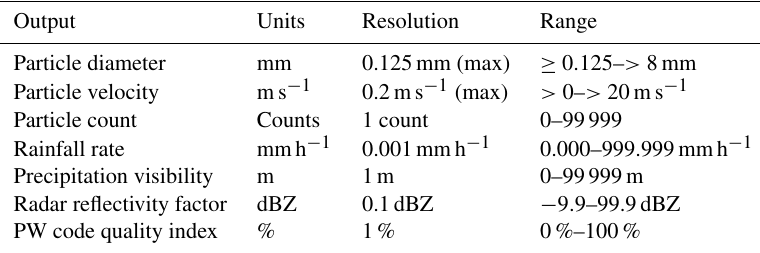
Table 1. Variable output from the Thies laser precipitation monitor (LPM).